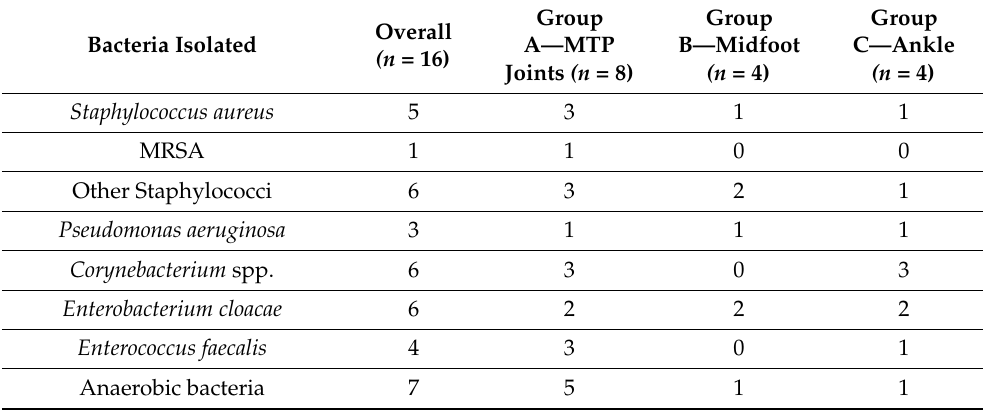
Table 2. Microbiological results of intraoperatively obtained bone samples and adjacent soft tissue